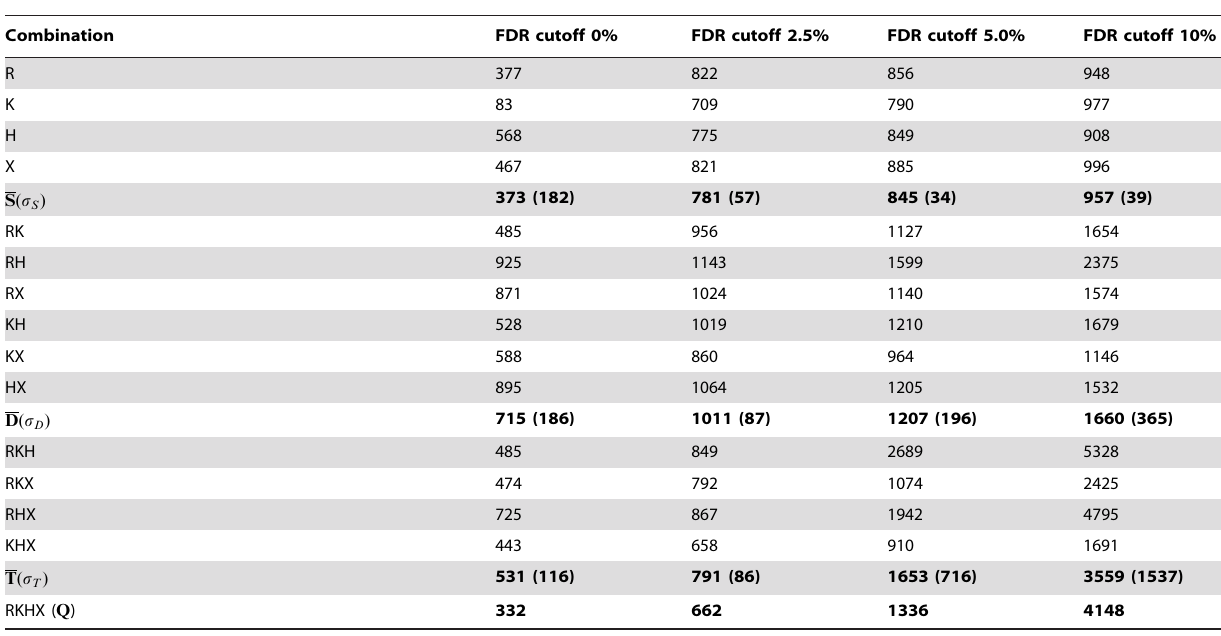
Table 2. Example retrieval tests based on